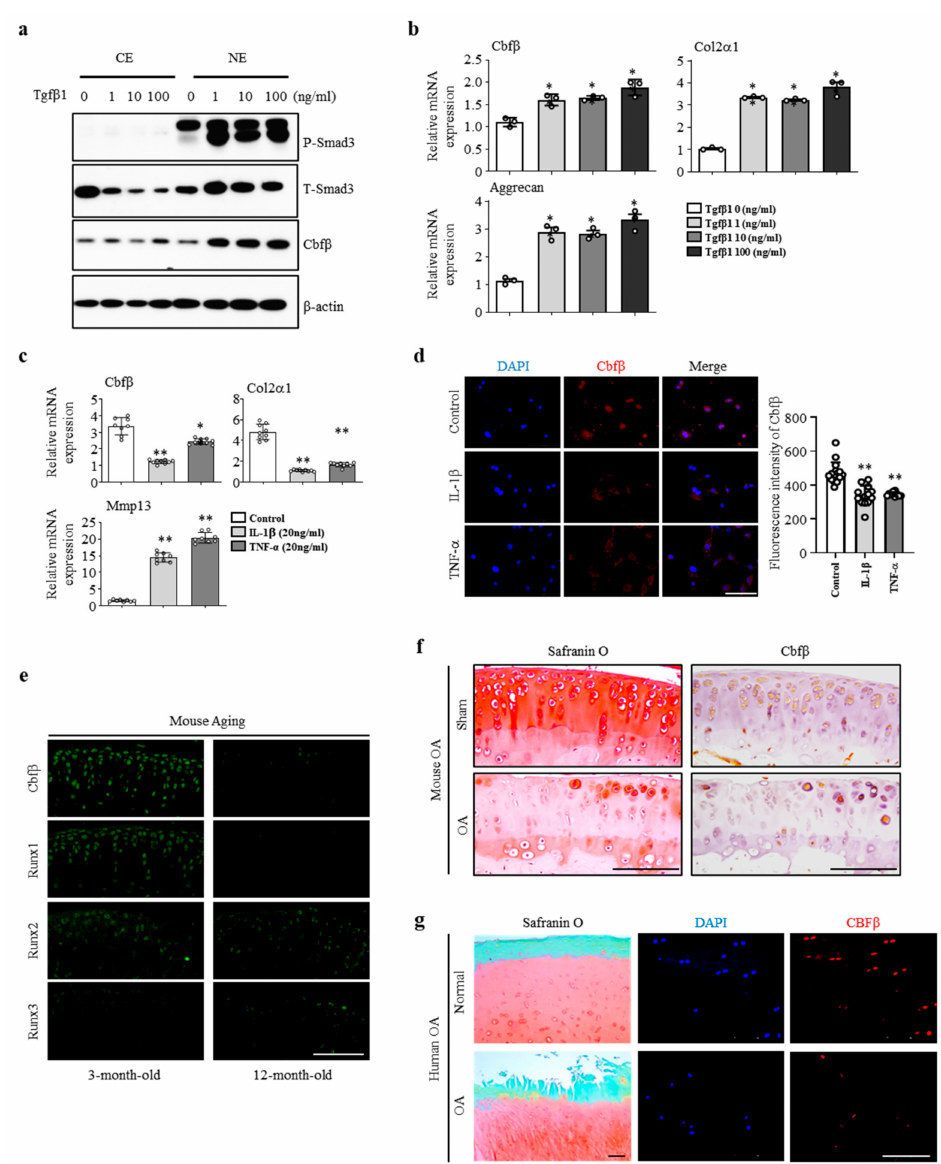
Figure 1. Cbf β loss is involved in OA pathogenesis. ( a ) Cbf β and pSmad 3 protein expression detected using Western blotting in articular chondrocytes with TGF- β 1 treatment. CE, cytoplasmic extracts; NE, nuclear extracts; ( b ) Cbf β , Col2 α 1, and Aggrecan mRNA expression detected by qRT-PCR in articular chondrocytes with TGF- β 1 treatment. * p < 0.05 vs. TGF- β 1 0 (ng/ml). ( c ) Cbf β , Cols2 α 1, and Mmp13 mRNA expression detected by qRT-PCR in articular chondrocytes with IL-1 β or TNF- α treatment. * p < 0.05, ** p < 0.01 vs. control. ( d ) Cbf β detection by immunofluorescence staining after treatment of IL-1 β and TNF- α in articular chondrocytes. Scale bars, 100 µ m. ( e ) Expression of Cbf β , Runx1, Runx2, and Runx3 at 3 and 12 months of age was evaluated with immunofluorescence staining ( n = 3). Scale bars, 100 µ m. ( f ) Mouse joint OA development was assessed with Safranin O staining and Cbf β expression was confirmed by immunohistochemical staining. Scale bars, 100 µ m. ( g ) Human OA development was assessed with Safranin O staining. DAPI staining, and Cbf β expression was conducted with immunofluorescent staining ( n = 6). Scale bars, 100 µ